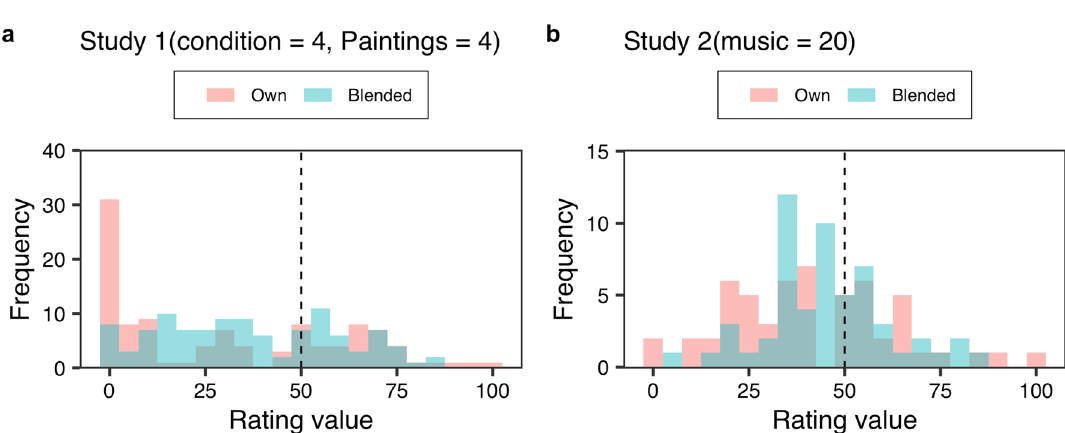
Figure 4. Typical example of the results in Study 1( a ) and Study 2( b ). Each histogram indicates the number of participants (Frequency). The titles represent the stimulus numbers (see Supplementary Tables S1 and